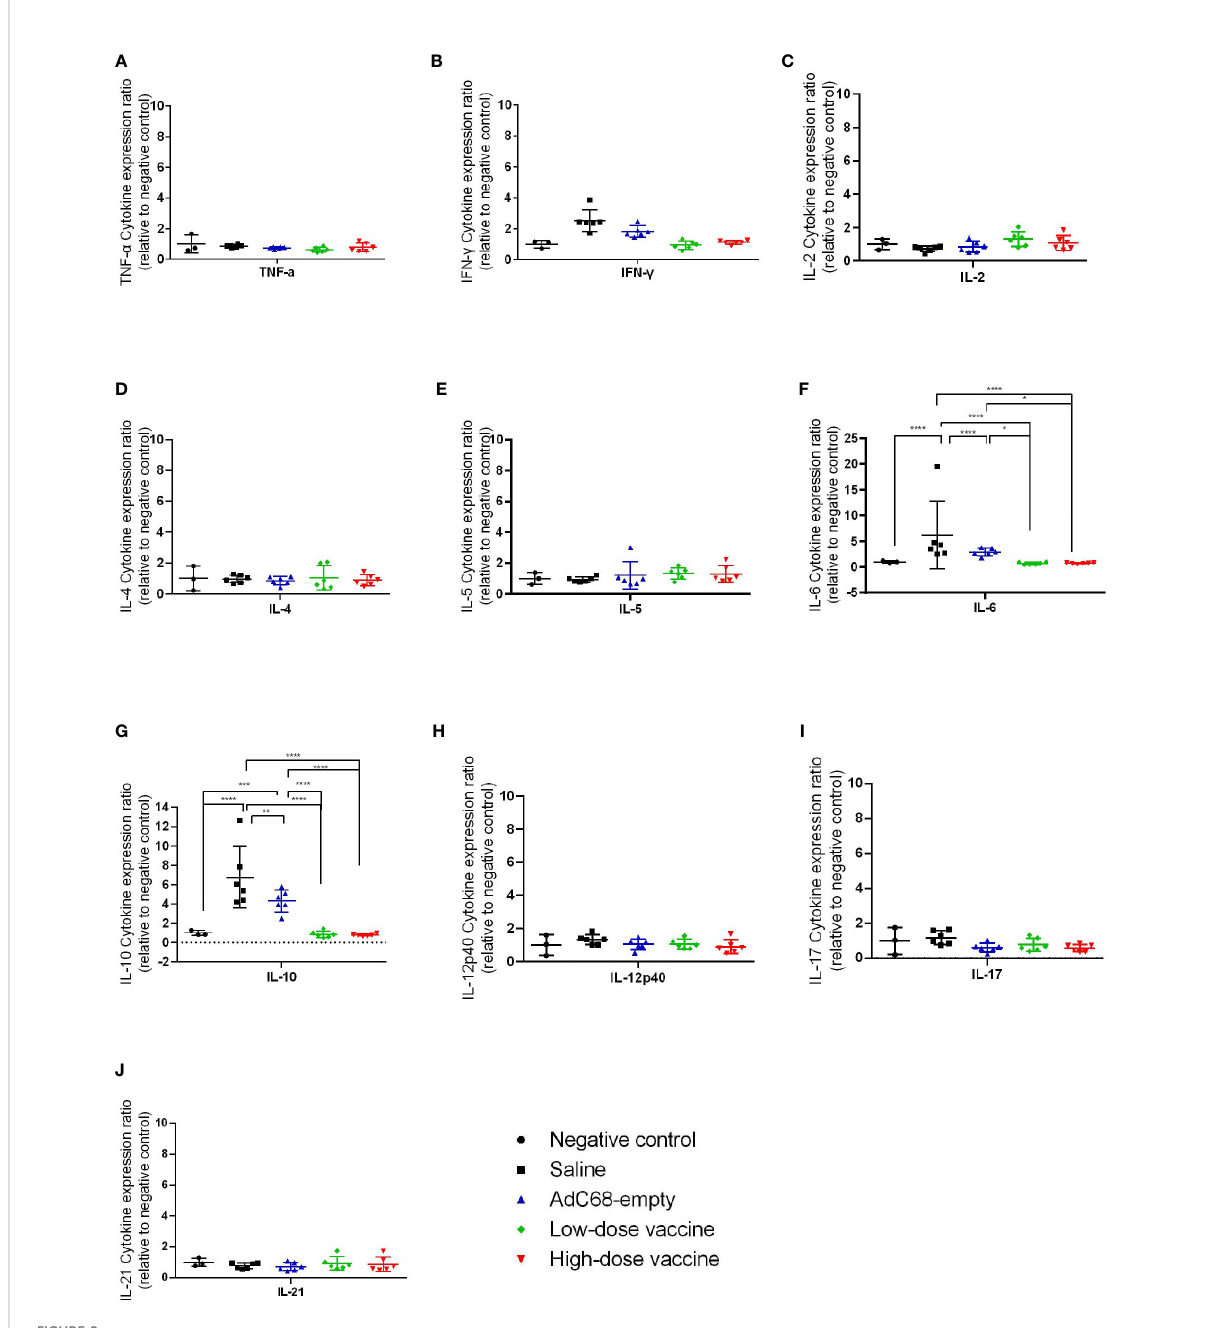
FIGURE 8 Ratios of cytokine expression levels in the lungs of golden Syrian hamsters at dpi 7. The cytokine expression levels in the lungs of golden Syrian hamsters were determined by RT-qPCR at dpi 7. (A) Ratios of TNF- a cytokine expression levels in the lungs of golden Syrian hamsters at dpi 7, (B) Ratios of IFN- g cytokine expression levels in the lungs of golden Syrian hamsters at dpi 7, (C) Ratios of IL-2 cytokine expression levels in the lungs of golden Syrian hamsters at dpi 7, (D) Ratios of IL-4 cytokine expression levels in the lungs of golden Syrian hamsters at dpi 7, (E) Ratios of IL-5 cytokine expression levels in the lungs of golden Syrian hamsters at dpi 7, (F) Ratios of IL-6 cytokine expression levels in the lungs of golden Syrian hamsters at dpi 7, (G) Ratios of IL-10 cytokine expression levels in the lungs of golden Syrian hamsters at dpi 7, (H) Ratios of IL- 12p40 cytokine expression levels in the lungs of golden Syrian hamsters at dpi 7, (I) Ratios of IL-17 cytokine expression levels in the lungs of golden Syrian hamsters at dpi 7, (J) Ratios of IL-21 cytokine expression levels in the lungs of golden Syrian hamsters at dpi 7. * p < 0.05, ** p < 0.01, *** p < 0.001, **** p <